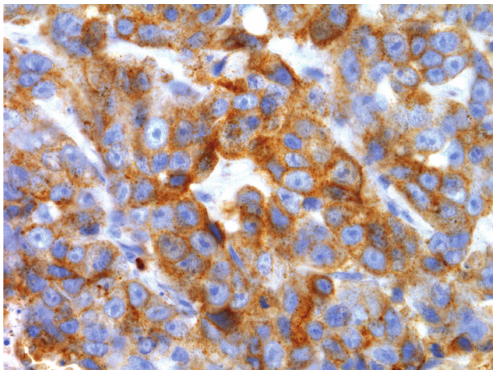
Figure 5: Solid carcinoma. Membranous and granular cytoplasmic aberrant P-cadherin immunoreactivity in luminal epithelial cells (streptavidin-biotin-peroxidase method, 630x).